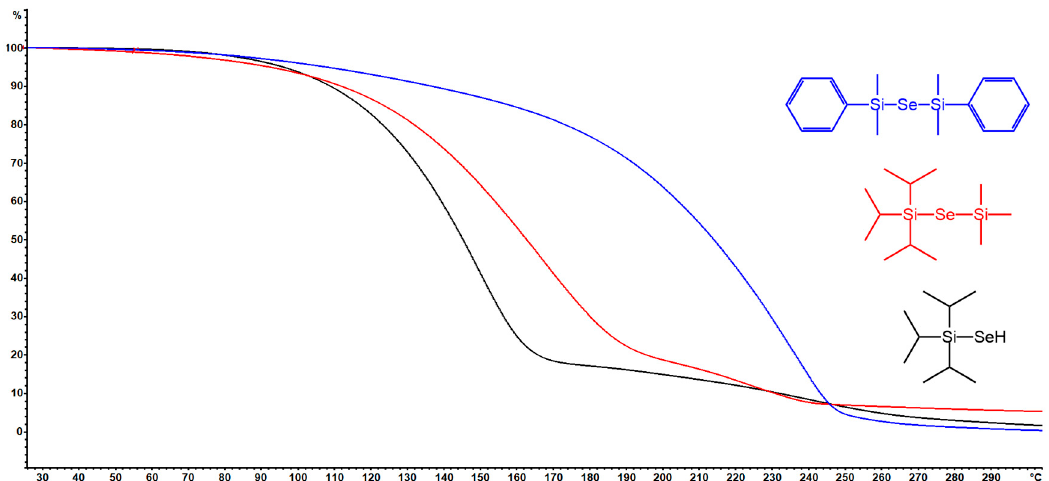
Figure 2. TGA curves for newly prepared organoselenium compounds.